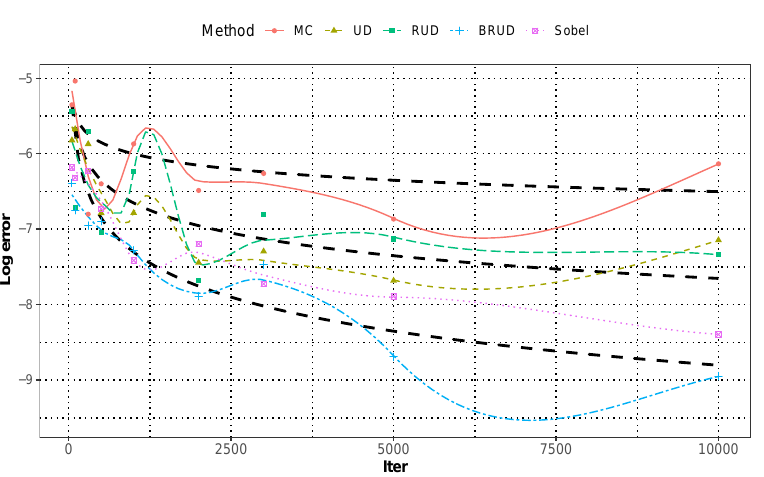
Figure 2. The approximation error of integration 1 for each runs in dimension s = 5 with locally weighted